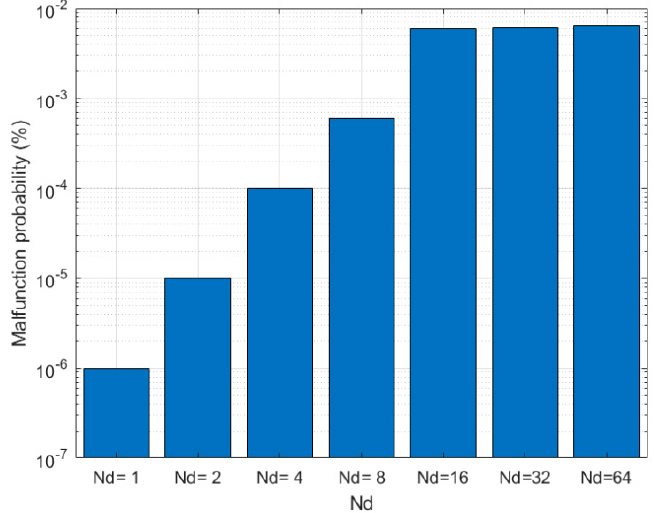
Figure 12. Results from the fourth experiment.